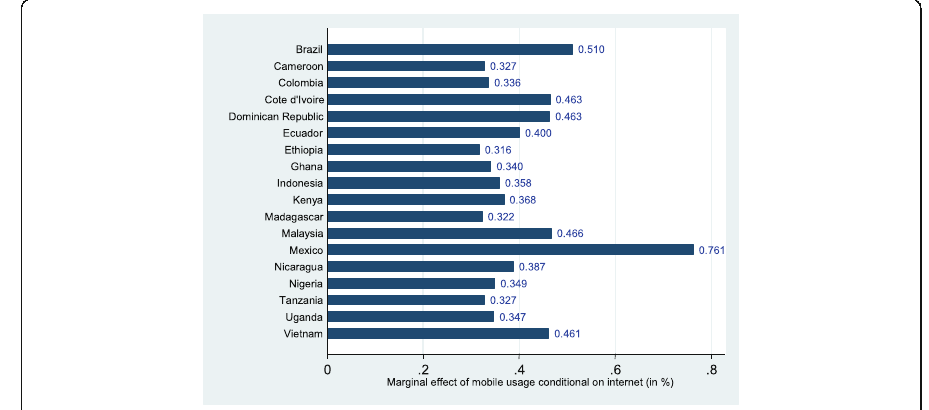
Fig. 4 Total effect of mobile phone usage on nominal rate of assistance by